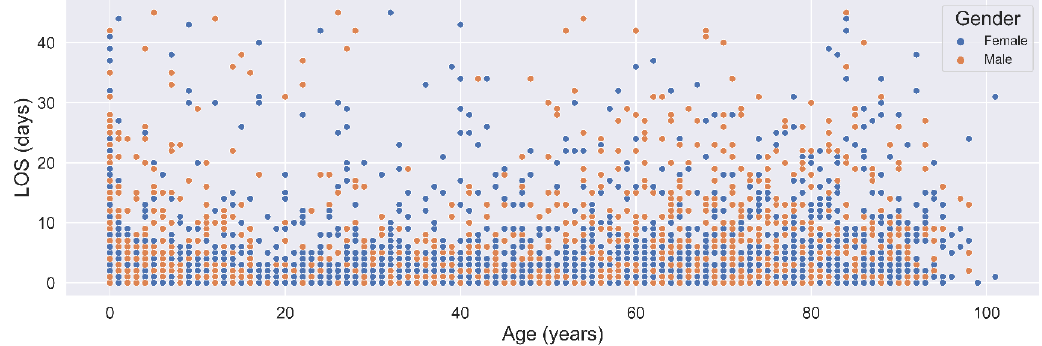
Figure 5. Correlation between age, LOS, and gender.